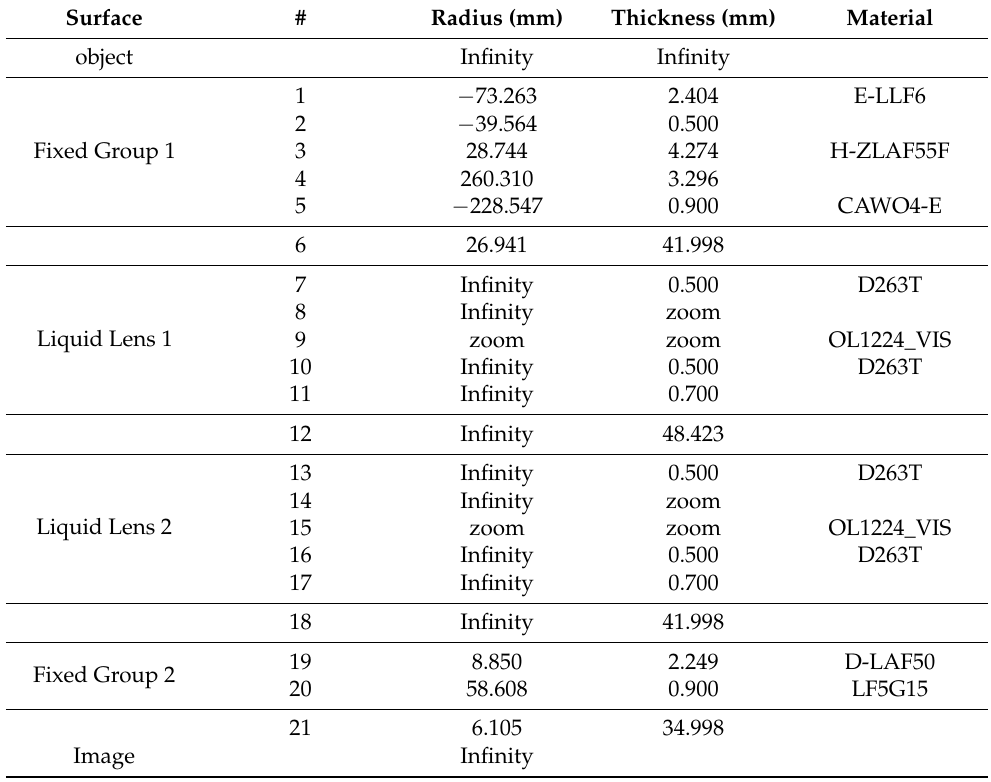
Figure 8. Final structure of the zoom system: ( a ) Focal length of the zoom system is 88.3547 mm; ( b ) Focal length of the zoom system is 150.096 mm; ( c ) Focal length of the zoom system is 204.62 mm. Table 4. Lens data results for the zoom system.